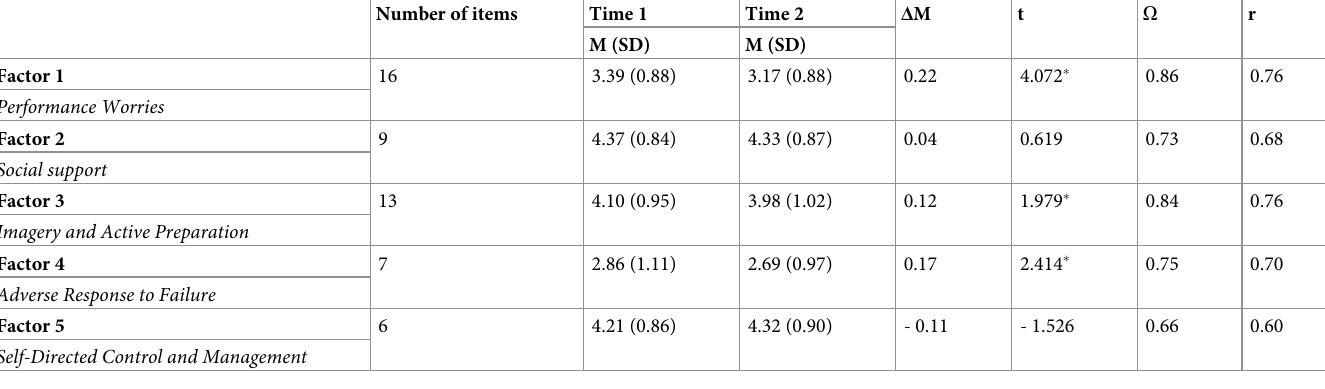
Table 4. Mean (M) and standard deviation (SD) of the two test moments per factor, and the difference in mean between time point 1 and 2 ( Δ M), also the McDonald Omega ( ω ) and Pearson correlation (r) between the items per